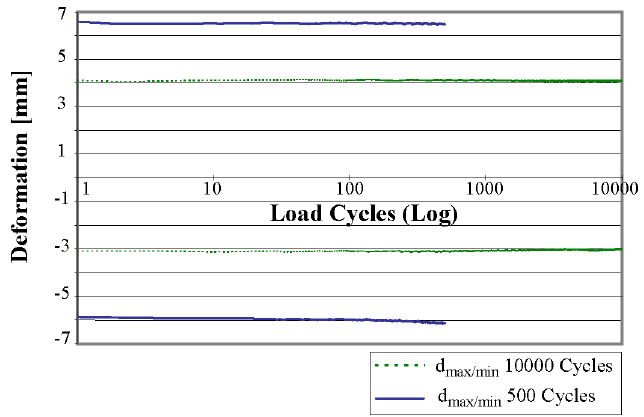
Figure 5: Deformation curves of PV-modules under different dynamic load